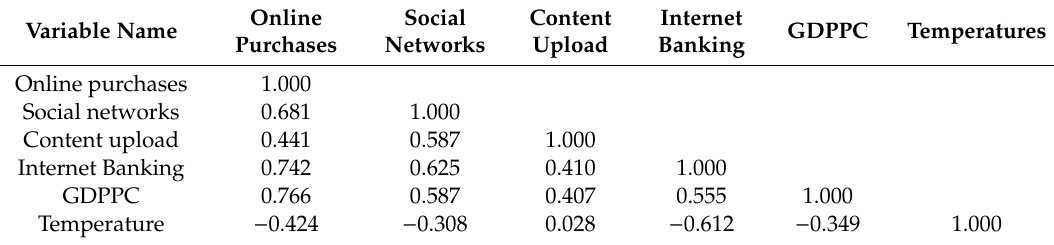
Table 4. Correlation between the variables in group